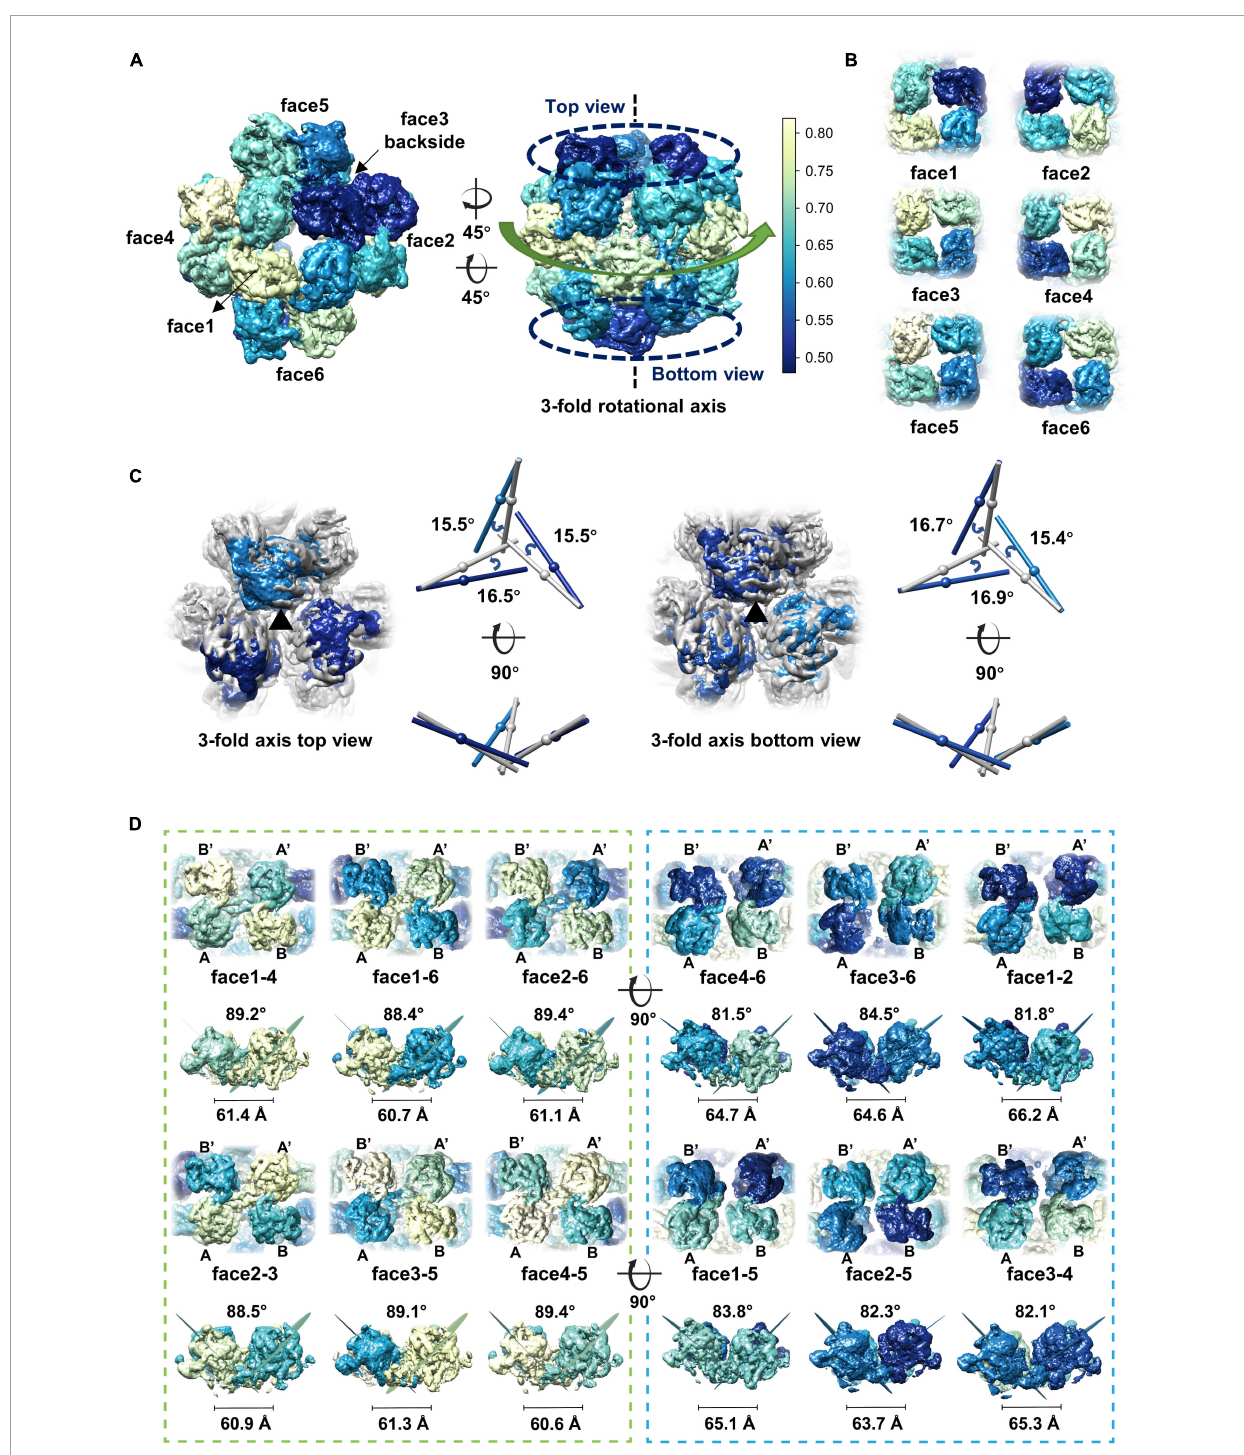
FIGURE3 Dynamics of the gp105 monomers in the cube-like assembly. (A) Surface rendered representations showing the cryo-EM maps with the C1 symmetry oriented around the 4-fold rotational axis (left) and the 3-fold rotational axis (right), respectively. Each molecule is colored according to the map CC values calculated with the superimposed C1 and O maps. The C1 map presented is contoured at 2.3 σ . (B) Surface rendered representations showing the six head-to-tail tetramers. Each molecule is colored according to the map CC values calculated with the superimposed C1 and O maps. ( C , Left) Surface rendered representations showing the top and bottom of the superimposed assemblies oriented around the 3-fold axis. Molecules in the O map are colored gray. Molecules in the C1 map are colored according to the CC values from light blue to dark blue. (Right) Comparisons of the long axes of the molecules in the O and C1 maps. The long axes of the molecules in the O and C1 maps are colored gray and blue, respectively. (D) Surface rendered representations showing all the concave tetramers in the map with C1 symmetry. The bending angle between the planes and the distance between the gravity centers of the two symmetrical subunits AB’ and A’B on the concave tetramers were calculated and